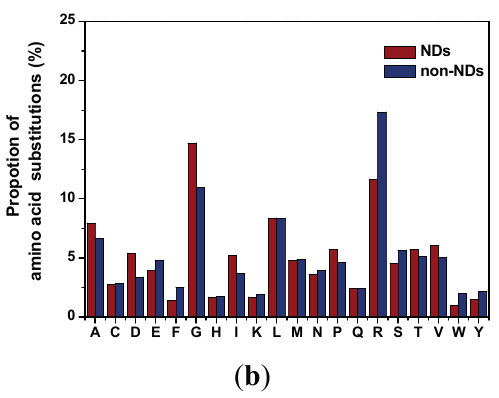
Figure 1. ( a ) The distribution of nucleotide substitution types and their proportions of NDs in comparison with non-NDs; ( b ) The amino-acid substitution spectrum of disease-causing missense mutations in NDs and